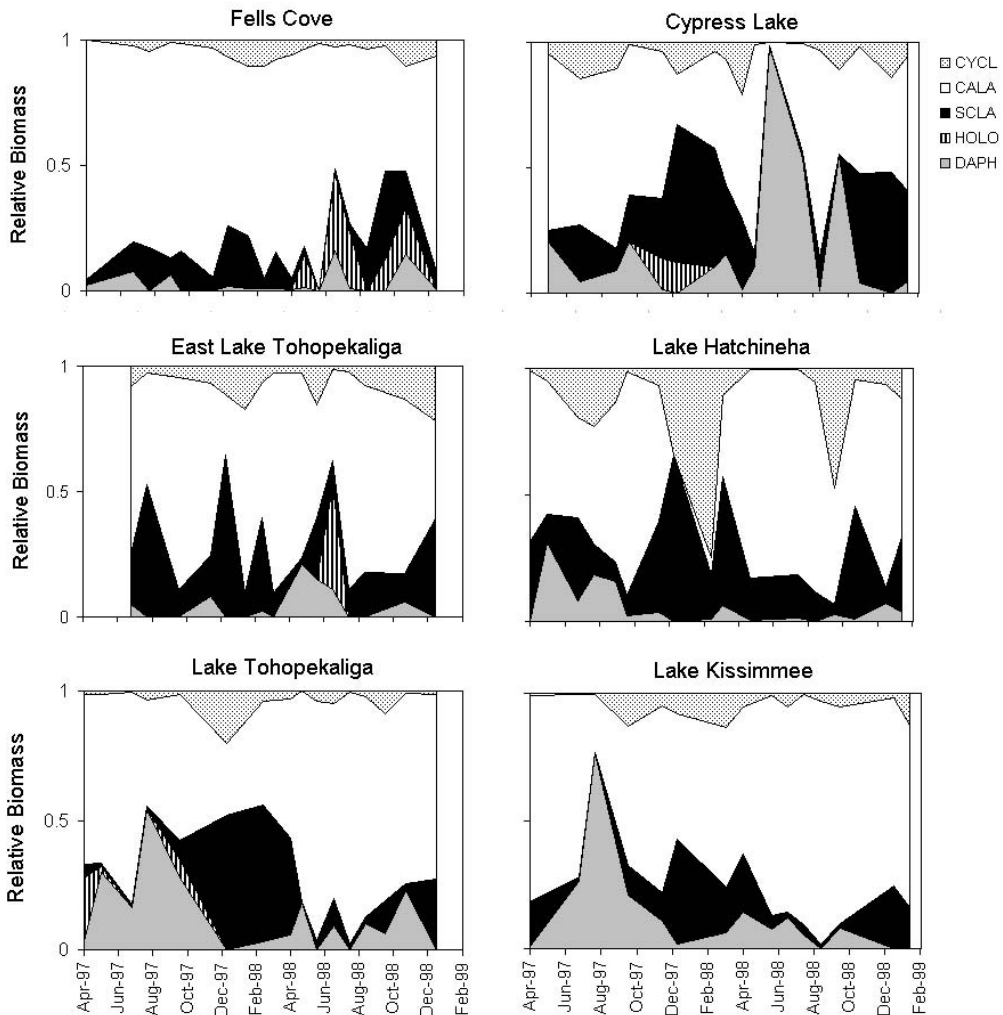
FIGURE 5. Relative biomass of various zooplankton taxonomic groups in the Kissimmee Chain-of-Lakes during 1997 to 1998. Taxa codes: CYCL = cyclopoid adults and copepodids; CALA = calanoid adults and copepodids; SCLA = small cladocerans; HOLO = Holopedium gibberum ; DAPH = Daphnia